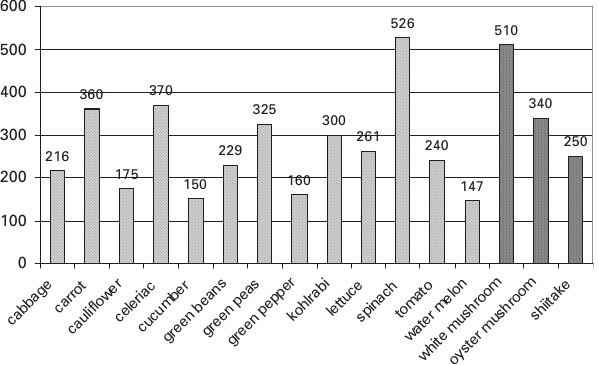
Figure 4. Average content of potassium (mg) in 100 g vegetables and mushrooms (fresh)